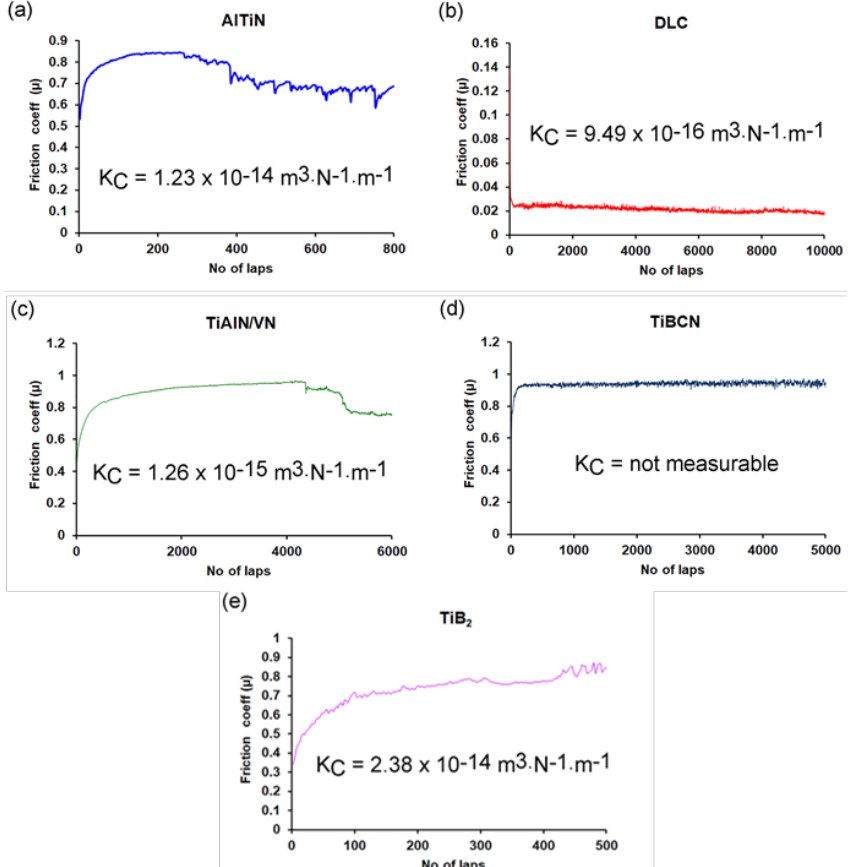
Figure 7. Friction coefficients recorded under 5 N normal load when sliding against Al 2 O 3 ball at